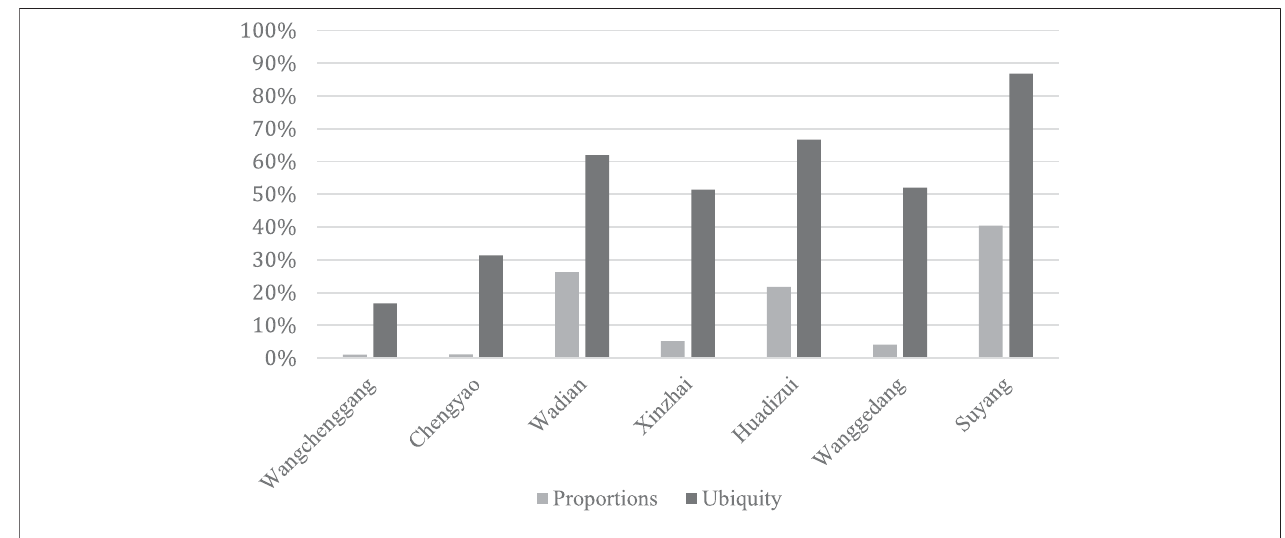
FIGURE 7 | Proportions and ubiquity of rice in the Longshan period at the Central Plain.